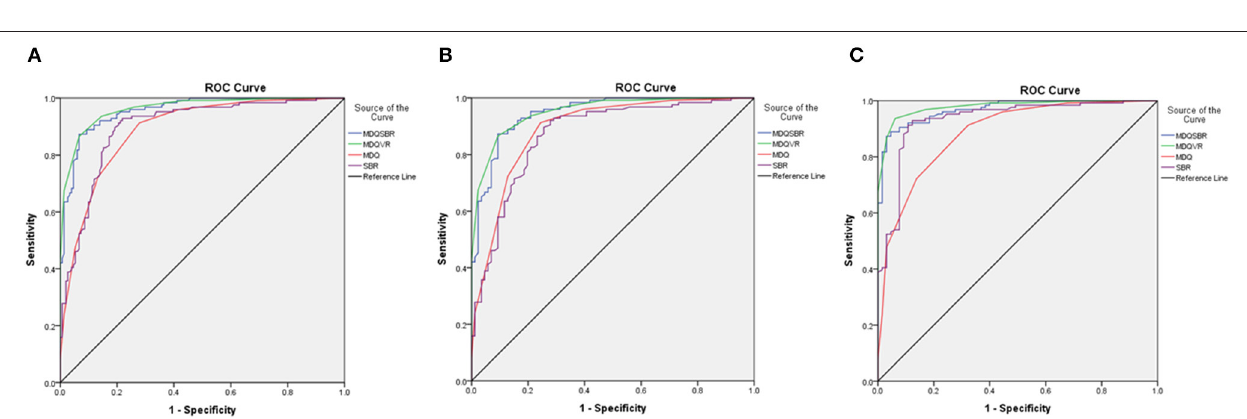
FIGURE 3 | Comparison of ROC curves of MDQ, SBR, MDQSBR composite scale, and MDQVR composite scale among ND, AD, and DLB groups. (A) DLB vs. non-DLB (ND + AD). (B) DLB vs. AD. (C) DLB vs. ND. ROC, receiver operating characteristic; MDQ, motor dysfunction questionnaire in the history-based artificial intelligence clinical dementia diagnostic system; SBR, striatal–background ratio of dopamine transporter imaging; MDQSBR, the composite scale of MDQ and SBR; MDQVR, the composite scale of MDQ and DAT VR scale; ND, non-dementia control; AD, Alzheimer’s disease dementia; DLB, dementia with Lewy